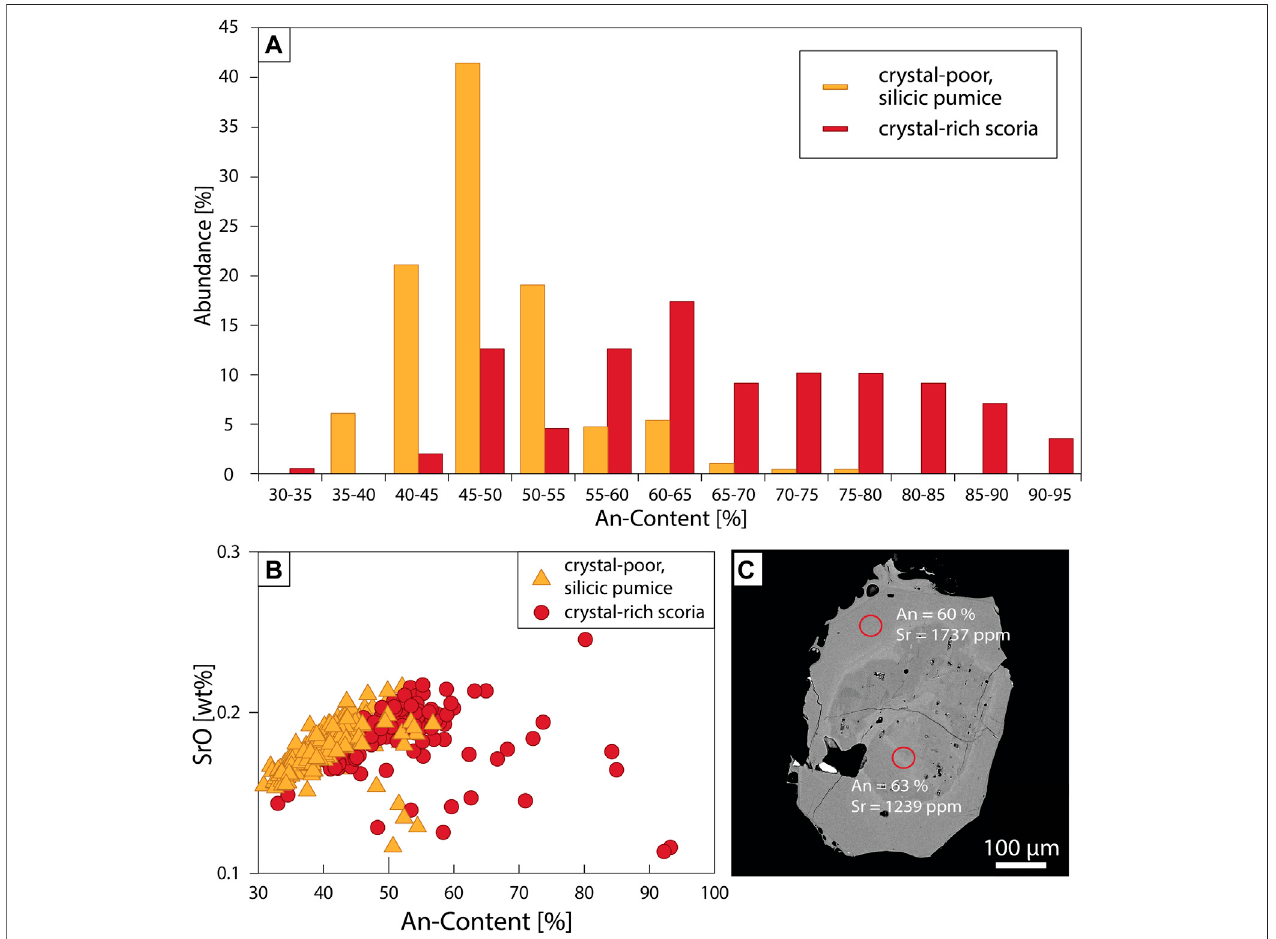
FIGURE 5 | Geochemical overview of Aso-4 plagioclases from crystal-rich scoria and crystal-poor, silicic pumice. (A) Histogram of An-contents of Aso-4 plagioclase. An contents for plagioclases overlap in the range of An 30 – 75 ; early-erupted plagioclases tend to cluster around lower An contents while plagioclases from late-eruptedunitstend toshifttowardhigher Ancontents.CrystalswithAn > 75areidenti fi edasrechargecrystalsbasedontestforequilibrium(followingPutirka,2016). (B) Binary plot of SrO vs. An-content displaying compositional overlap of plagioclase from early-erupted pumice and late-erupted scoria, with a tendency toward more ma fi c compositions in plagioclase from crystal-rich scoria. (C) Backscattered image of a plagioclase from late-erupted scoria exhibiting a sieved texture core overgrown by an euhedral rim of An 60 and clear Sr enrichment within the crystal rim. Measurement errors are smaller than the symbol.